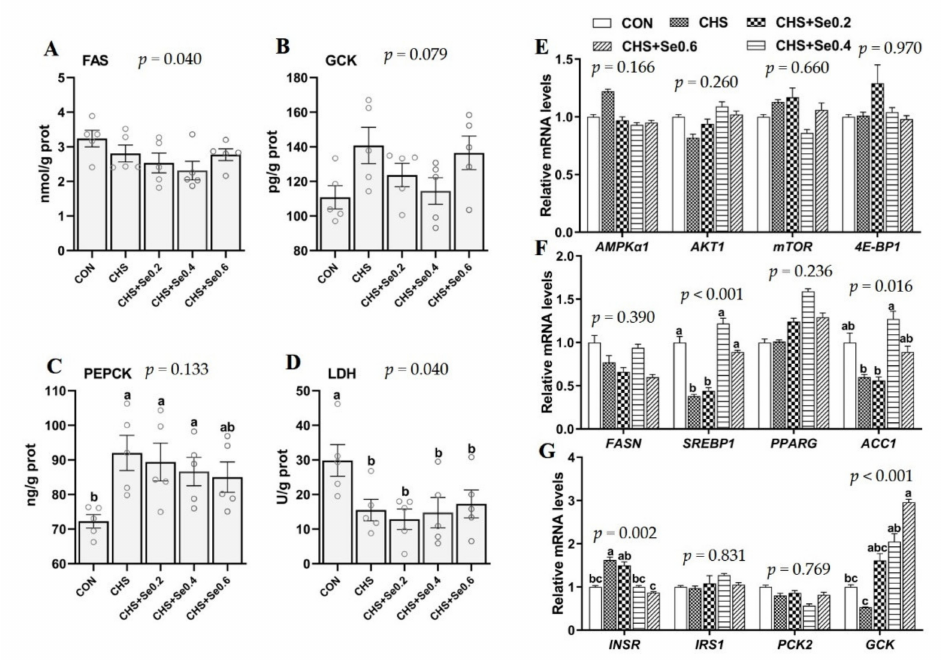
Figure 5. Effects of CHS and Se supplementation on enzyme activity ( A – D ) and expression of genes related to protein ( E ), lipid ( F ), and glucose ( G ) metabolism in longissimus dorsi muscle. The results are expressed as Mean ± SEM ( n = 4 or 6). Different letters (a, b, c, d) denote significant differences ( p <